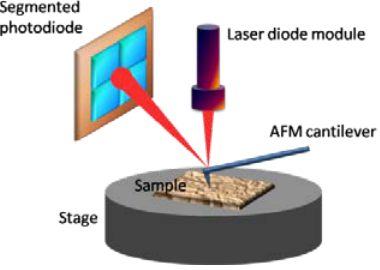
Figure 1. Optical beam deflection system.